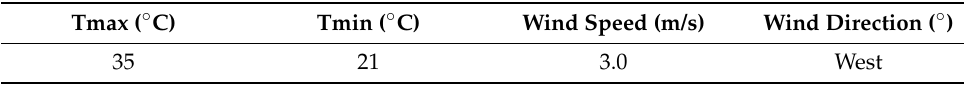
Table 3. Input data in the ENVI-met simulation model.